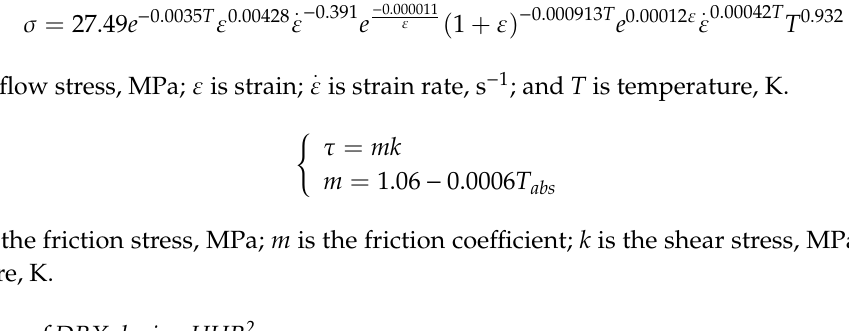
Figure 4. Finite element (FE) model and meshing for HHR 2 process.